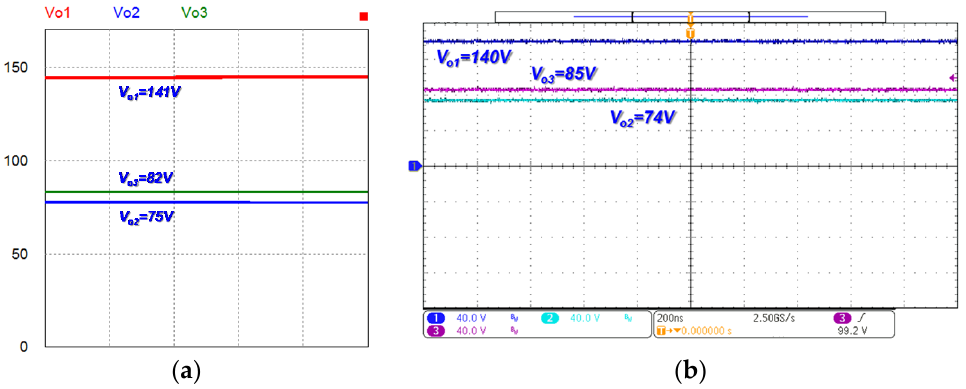
Figure 10. Output voltage waveforms in the battery discharging mode: ( a ) by simulation; and